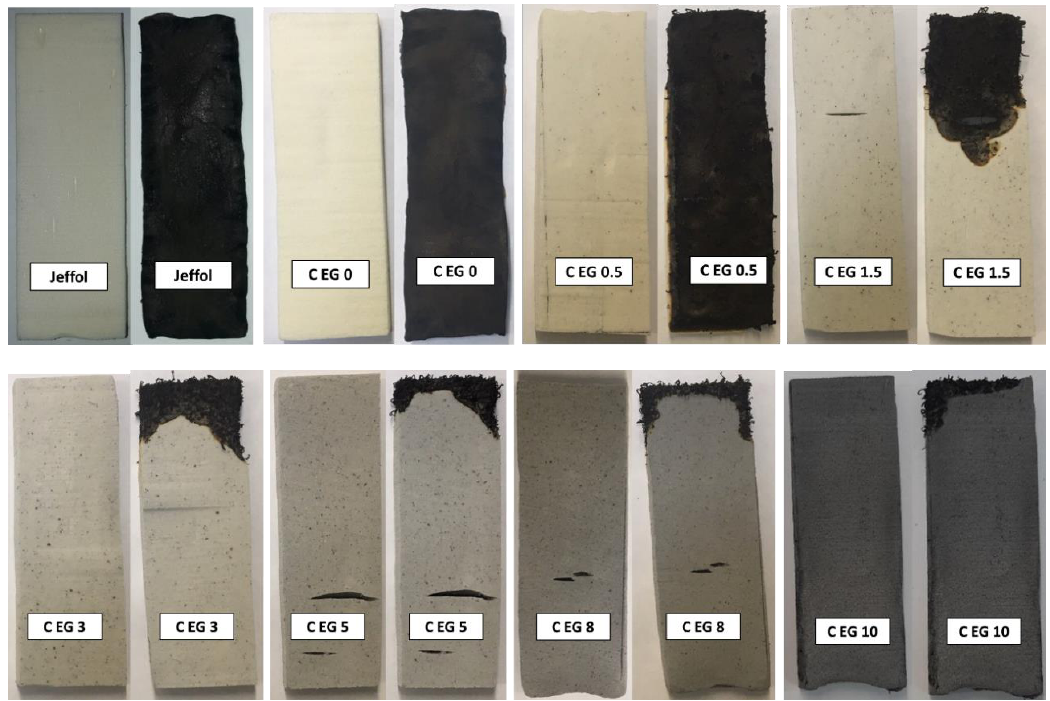
Figure 12. Photographs of the PU taken prior to and after the horizontal burning